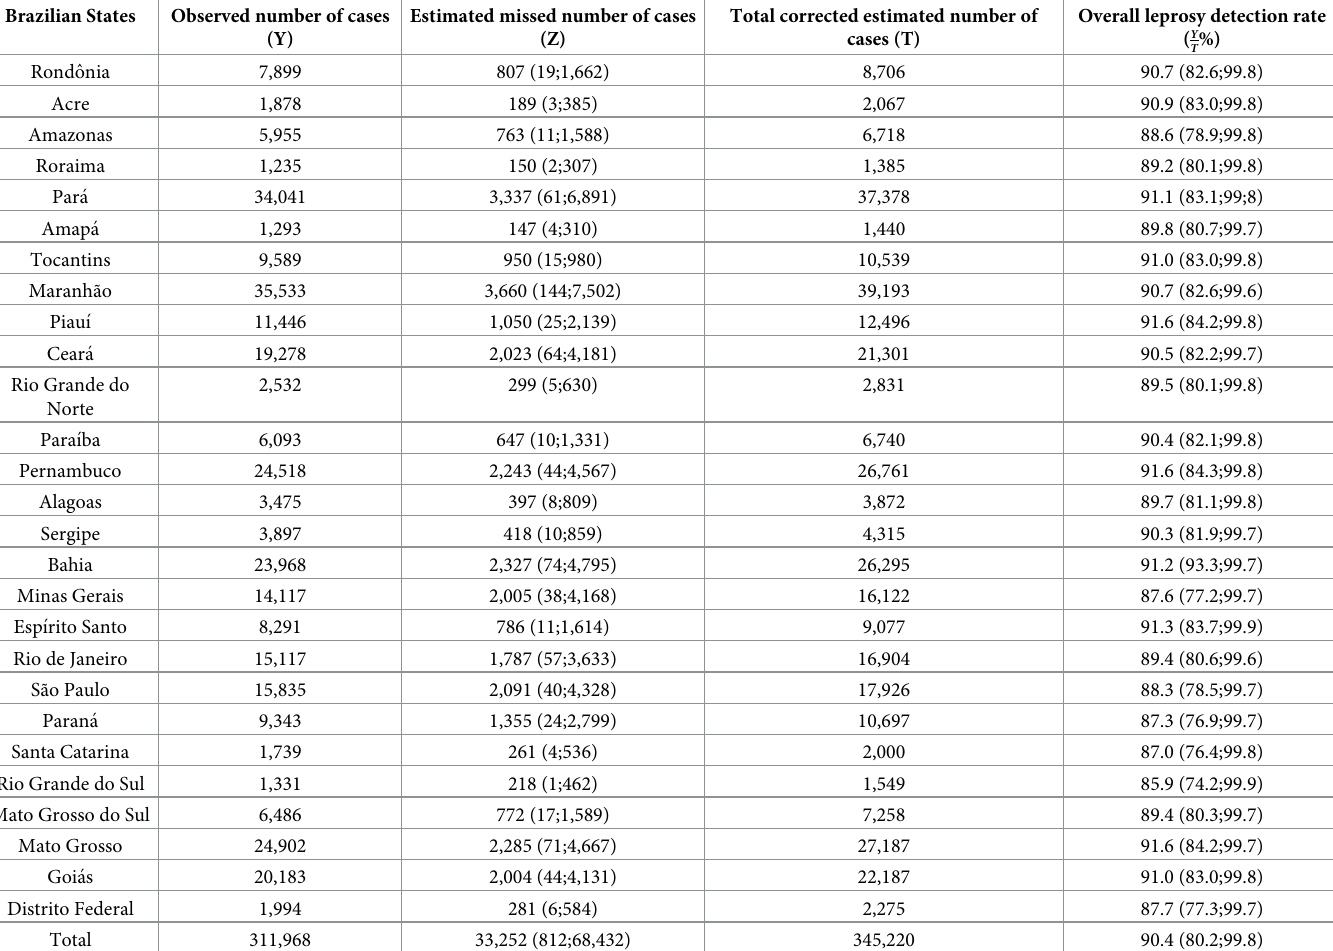
Table 1. Observed and estimated (posterior mean) number of new leprosy cases and overall leprosy detection rate for each Brazilian State for the period 2007–2015. The 90% highest posterior density (90%-HPD) interval is presented for the missed number o cases ( Z ) and for the detection rate. Brazilian States Observed number of cases